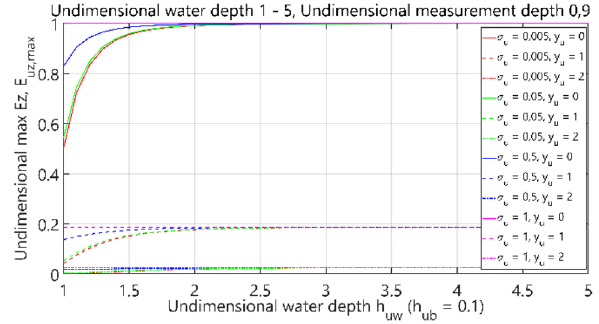
Figure 35. Dependence of E uz,max on h uw ( h ub = 0.1).